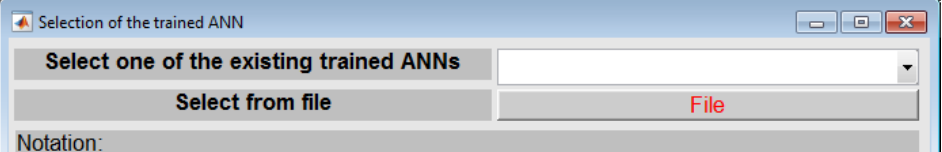
input earthquake ground motion selected.